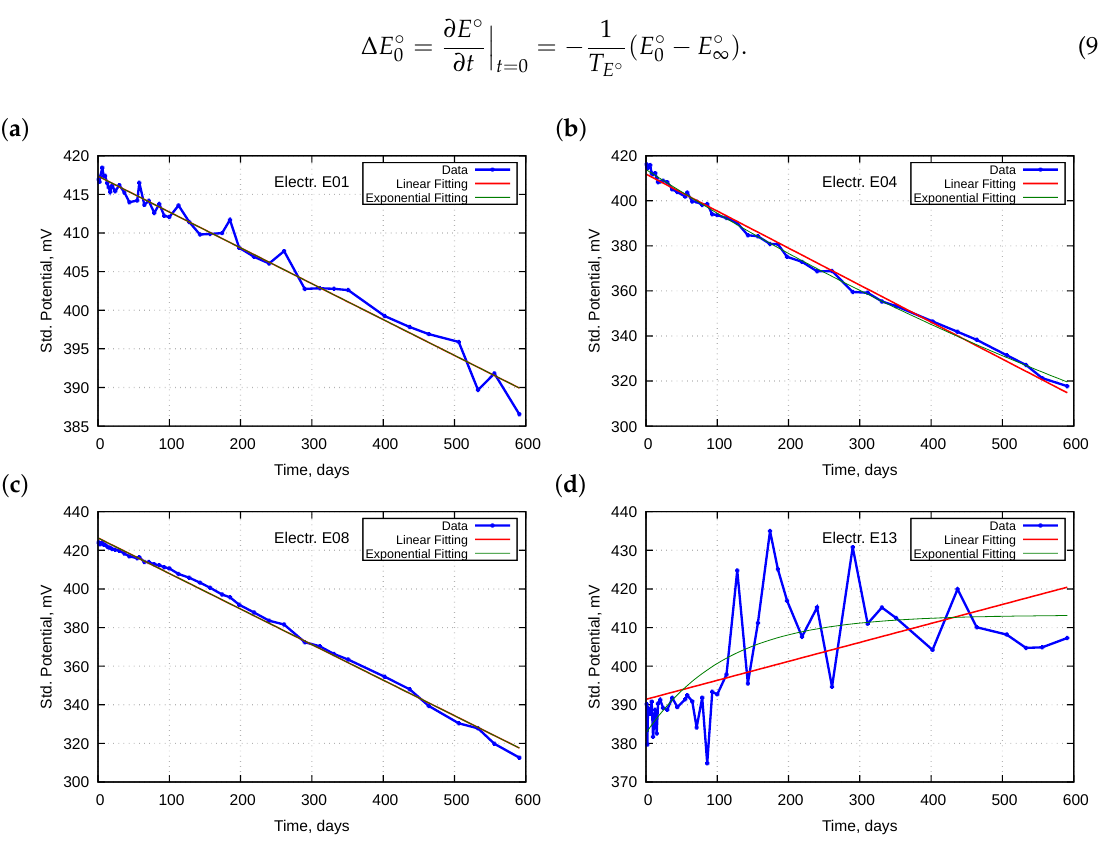
Figure 5. Examples of changes of electrode standard potentials in time for electrodes: ( a ) E01; ( b ) E04; ( c ) E08; and ( d ) E13.